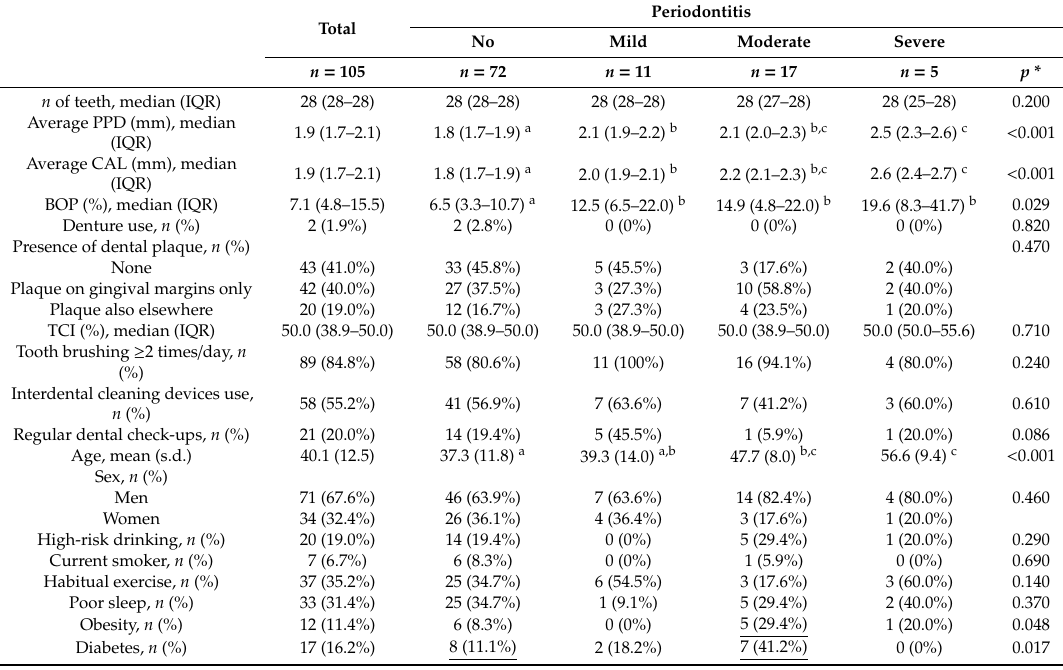
Table 1. Characteristics of the study population according to periodontitis